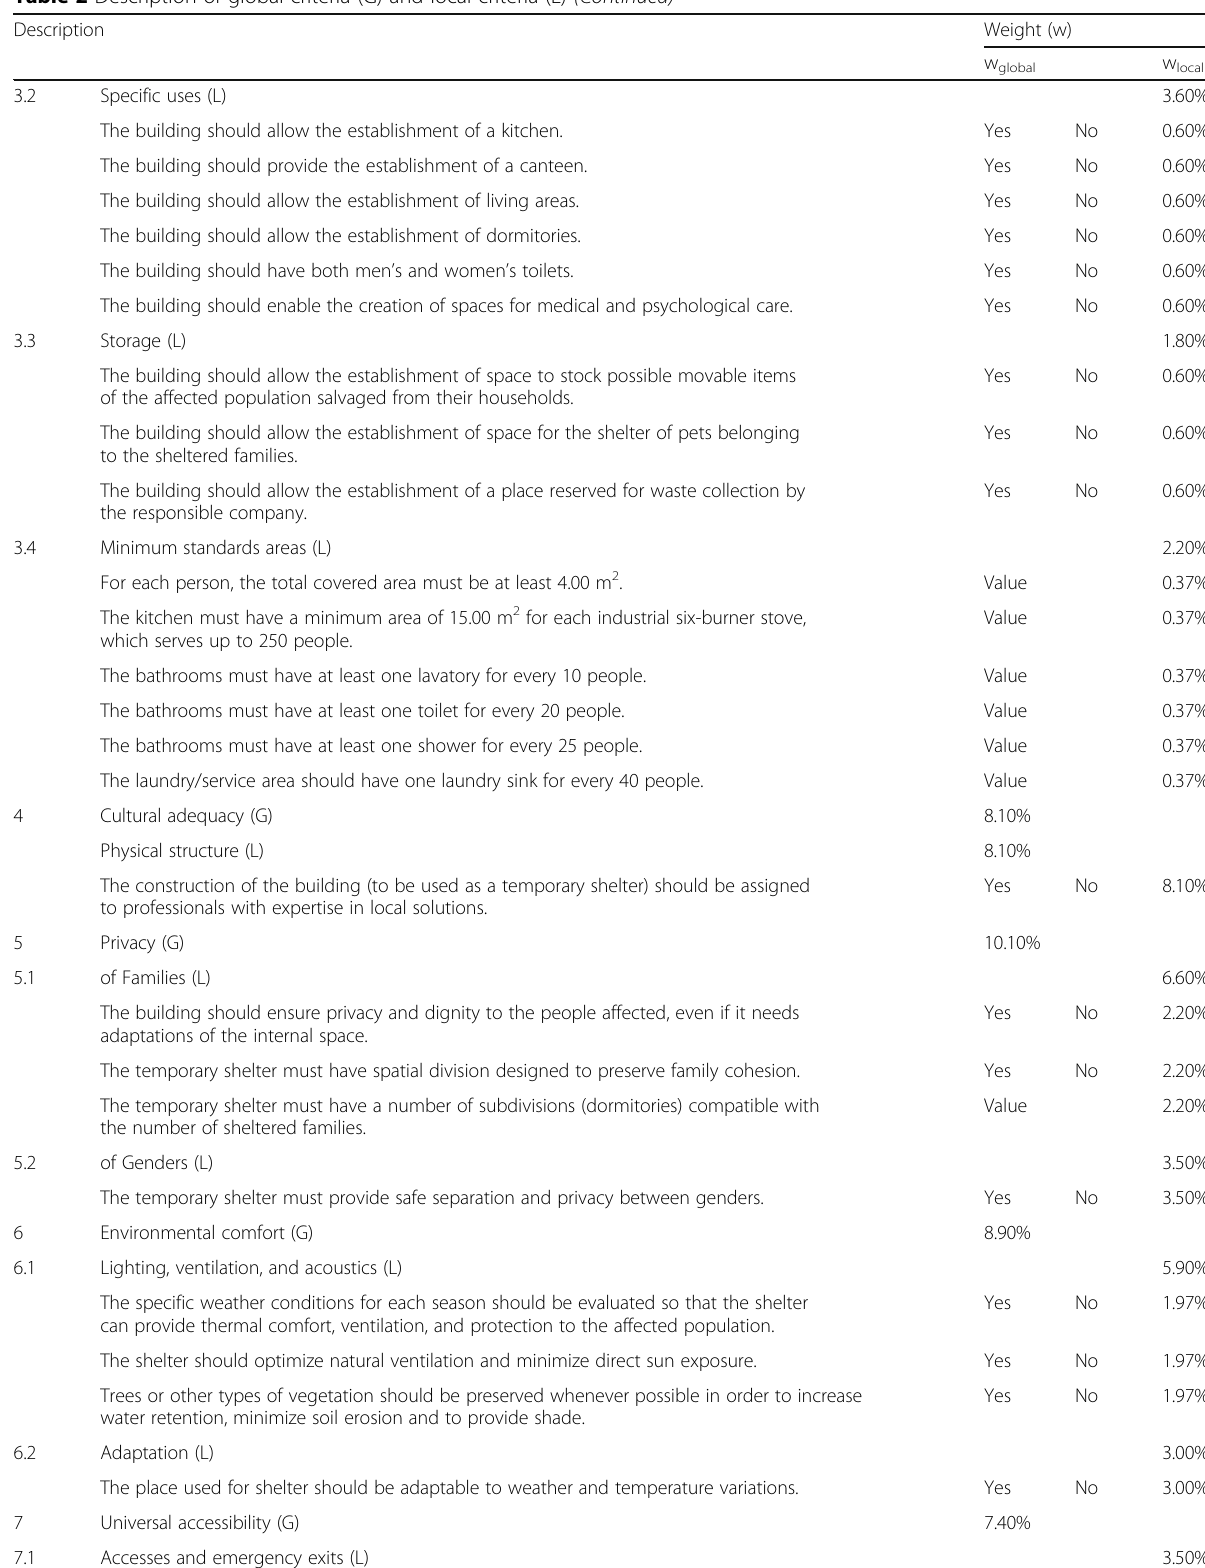
Table 2 Description of global criteria (G) and local criteria (L)